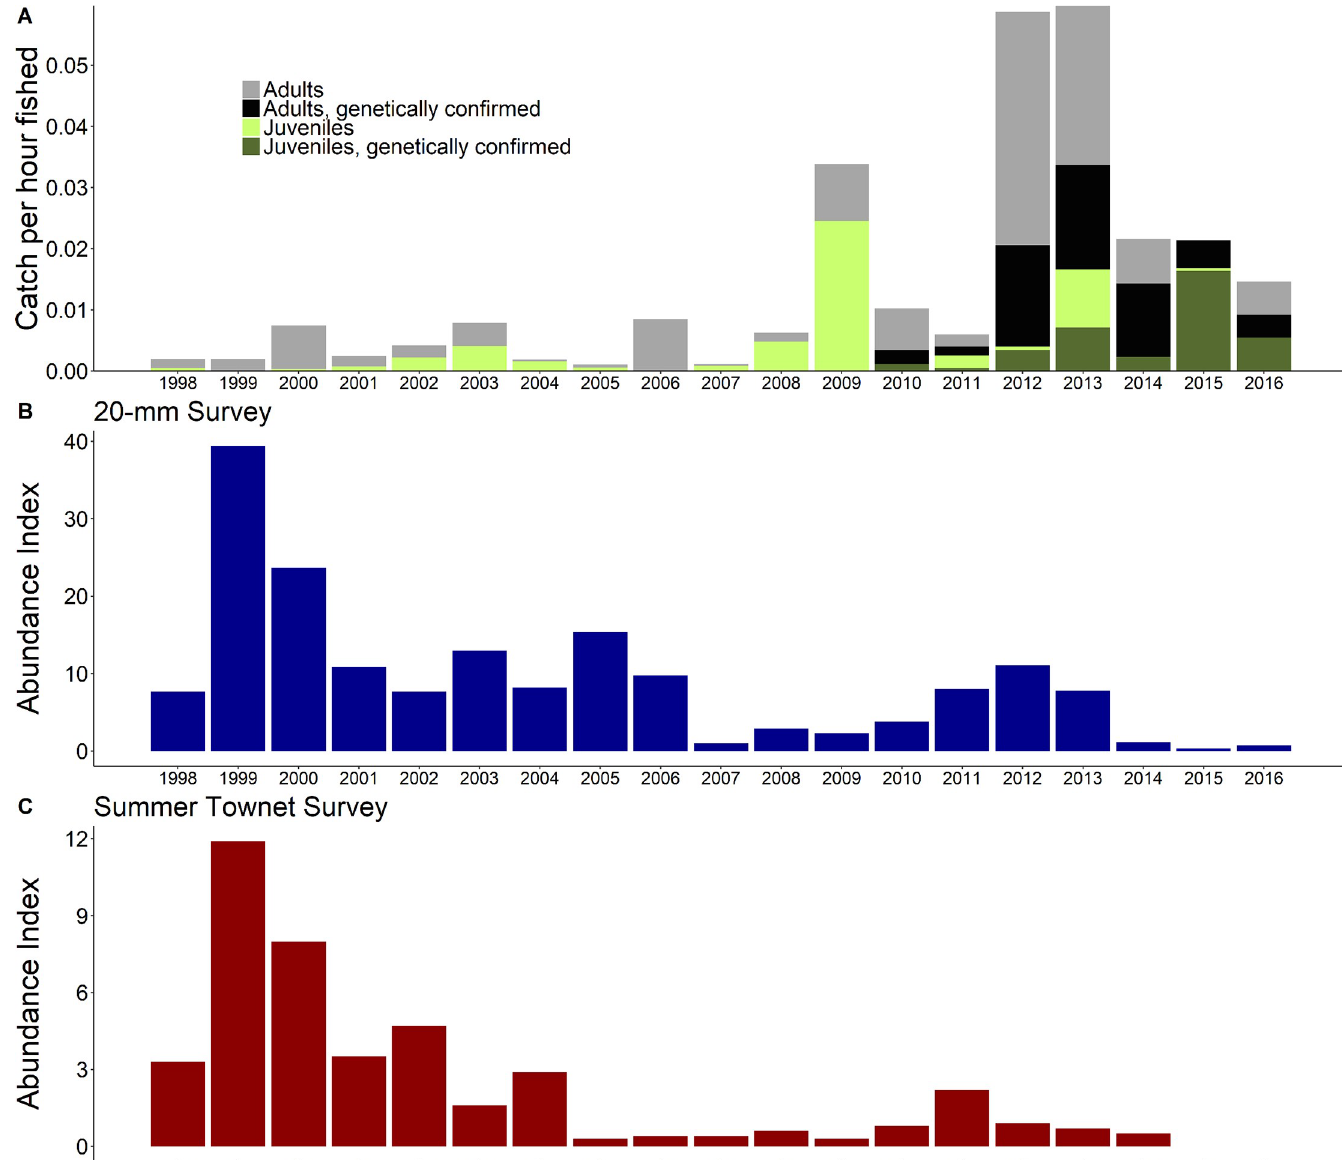
Fig 2. Catch per unit effort of Delta Smelt in the Yolo Bypass compared to elsewhere in the San Francisco Estuary: a.) Catch per hour of Delta Smelt in the Yolo Bypass rotary screw trap sorted by calendar year, life stage, and whether fish was genetically confirmed as Delta Smelt. b.) Abundance index from the 20-mm Survey [45]. c.) Abundance index from the Summer Townet Survey